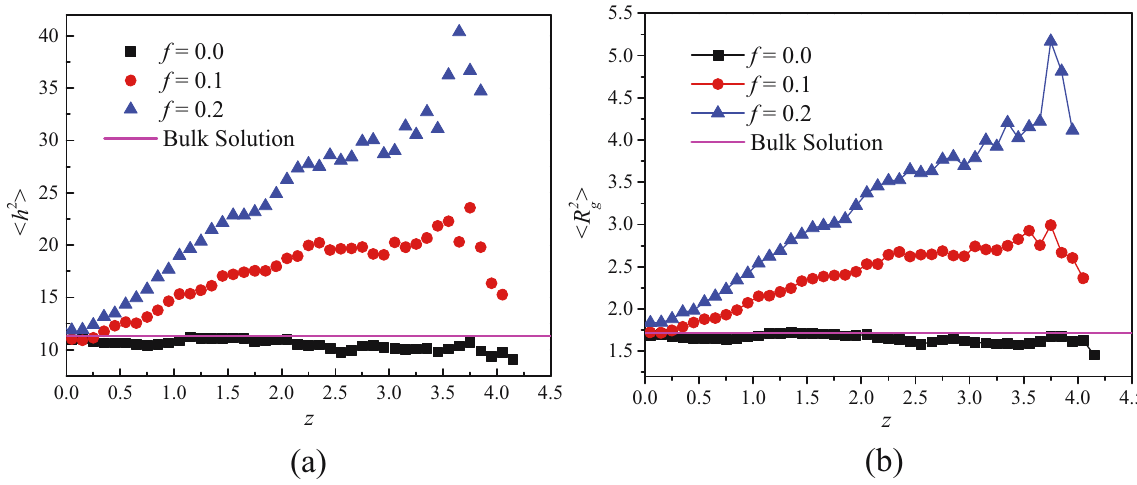
Figure 5: The wormlike chains ’ mean square end - to - end distance 〈 h 2 〉 and mean square radius of gyration 〈 〉 R g2 distribution across the slit for the driving force f = 0, 0.1, and 0.2, and for equilibrium simulation in large enough periodic domain ( i.e., bulk solution at equilibrium ) : ( a ) 〈 h 2 〉 distribution and ( b ) 〈 〉 R g2 distribution.